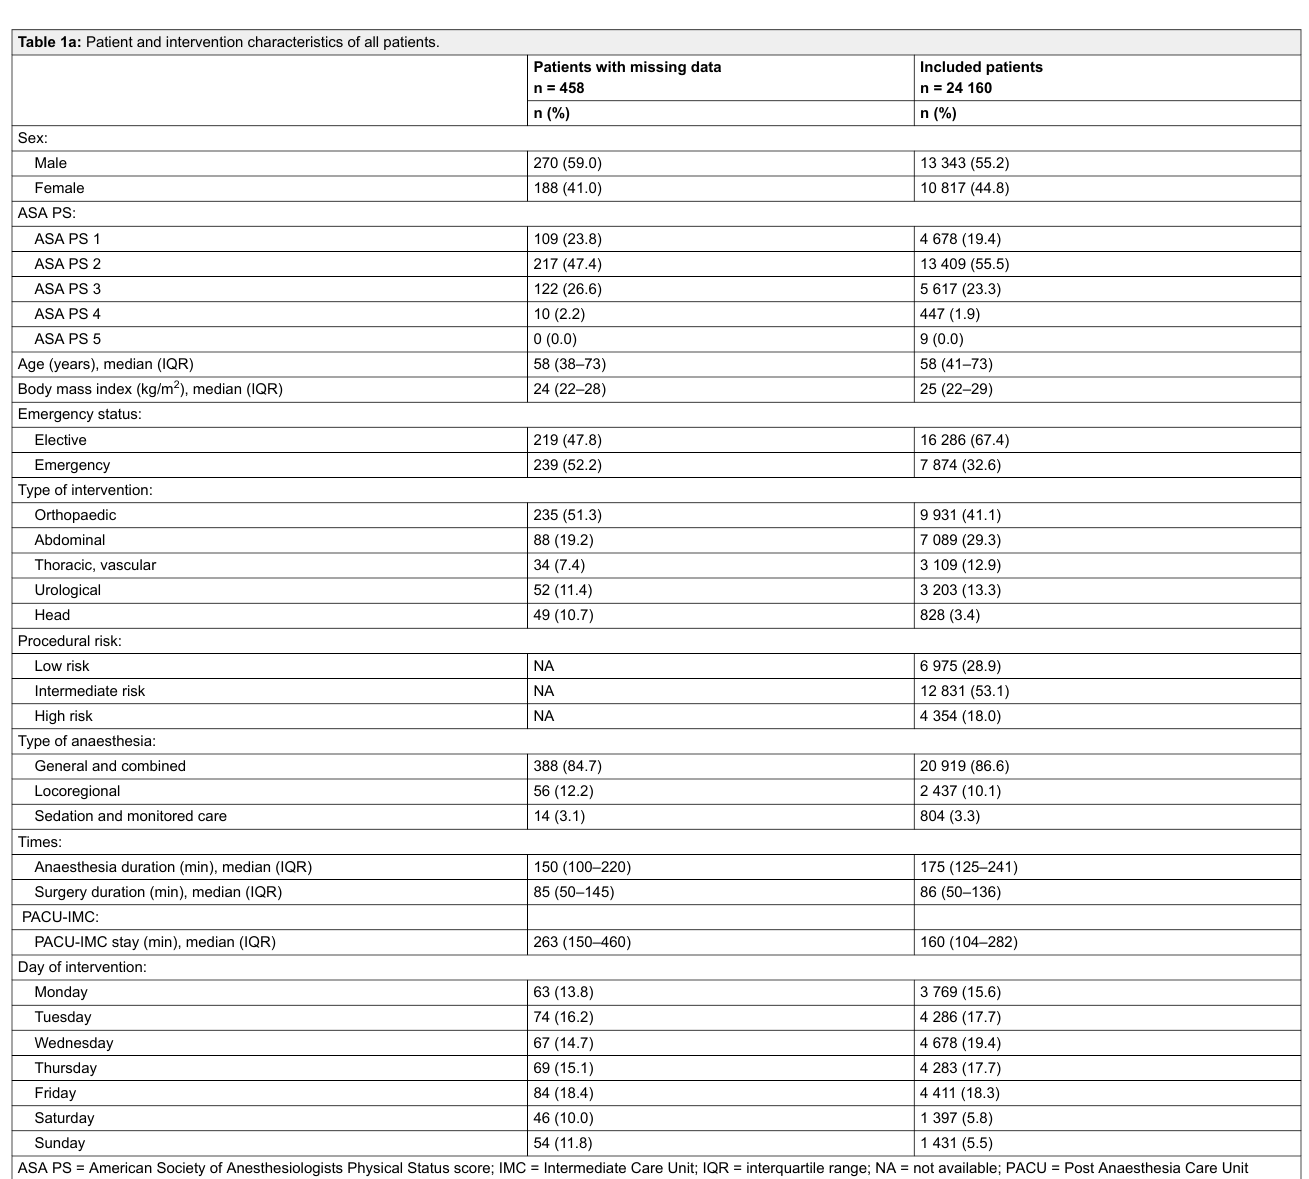
Table 1a: Patient and intervention characteristics of all patients.